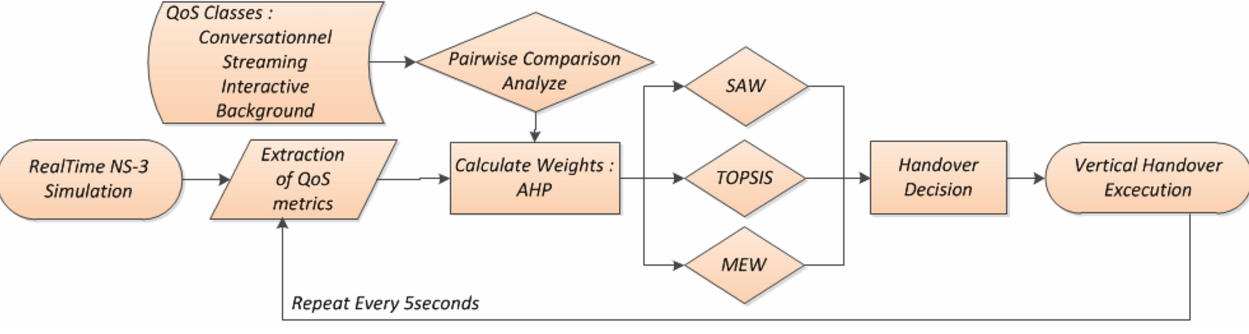
Figure 2. Algorithm